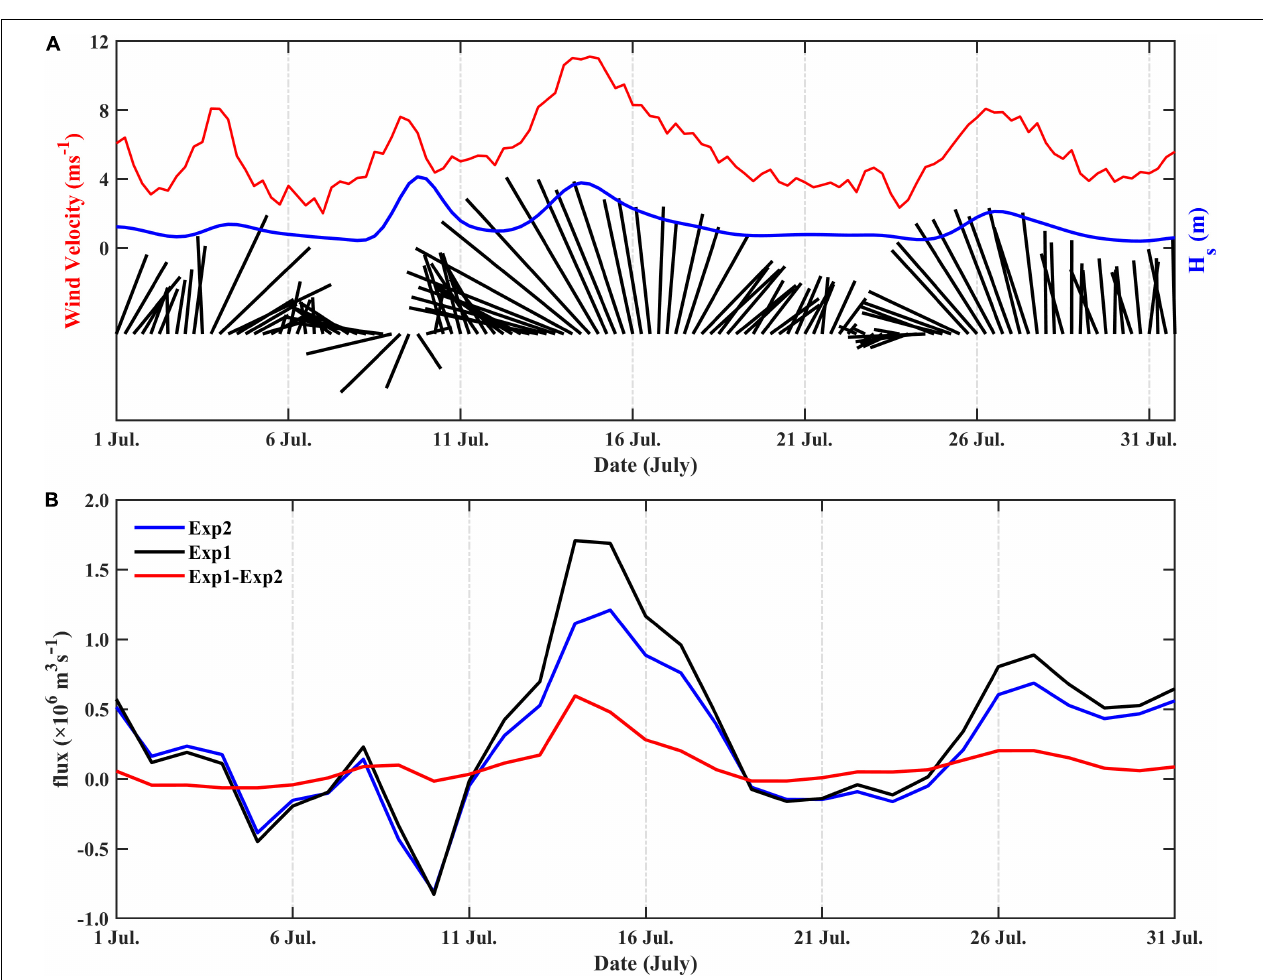
FIGURE 5 | (A) The wind vector (black), magnitude (red), and simulated significant wave height (blue) in the Changjiang River estuary (spatially-averaged within the range of Figure 4A ) during July 2006. (B) The daily-averaged current flux across the cross-section B (30 ◦ N, 122.5 ∼ 123.5 ◦ E) during July 2006. Positive indicates northward